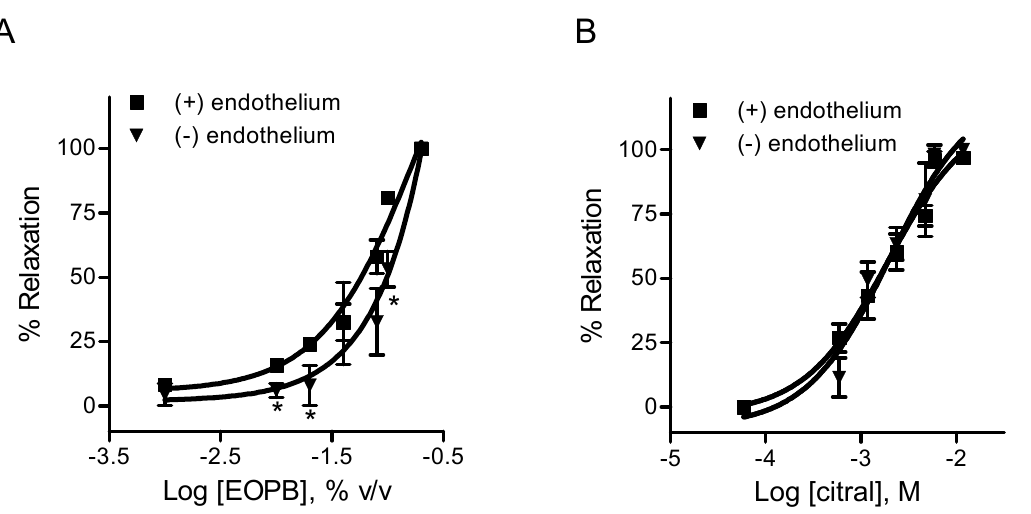
Figure 2. Concentration-response curves for essential oil of Pectis brevipedunculata (EOPB) ( a ) and citral ( b ) in endothelium-intact and denuded aorta from Wistar-Kyoto rats, precontracted with phenylephrine. Data are mean ± SEM (n = 4). * p < 0.05 vs.